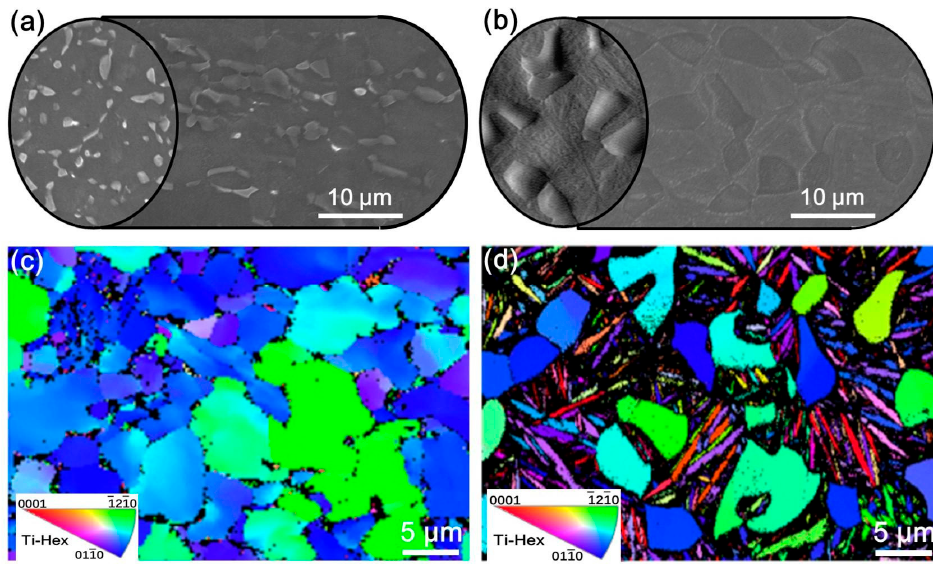
Figure 15. SEM images after ( a ) drawing and rolling, and ( b ) after STA and Inverse pole figures after ( c ) drawing and rolling, and ( d ) heading and STA processes [98].